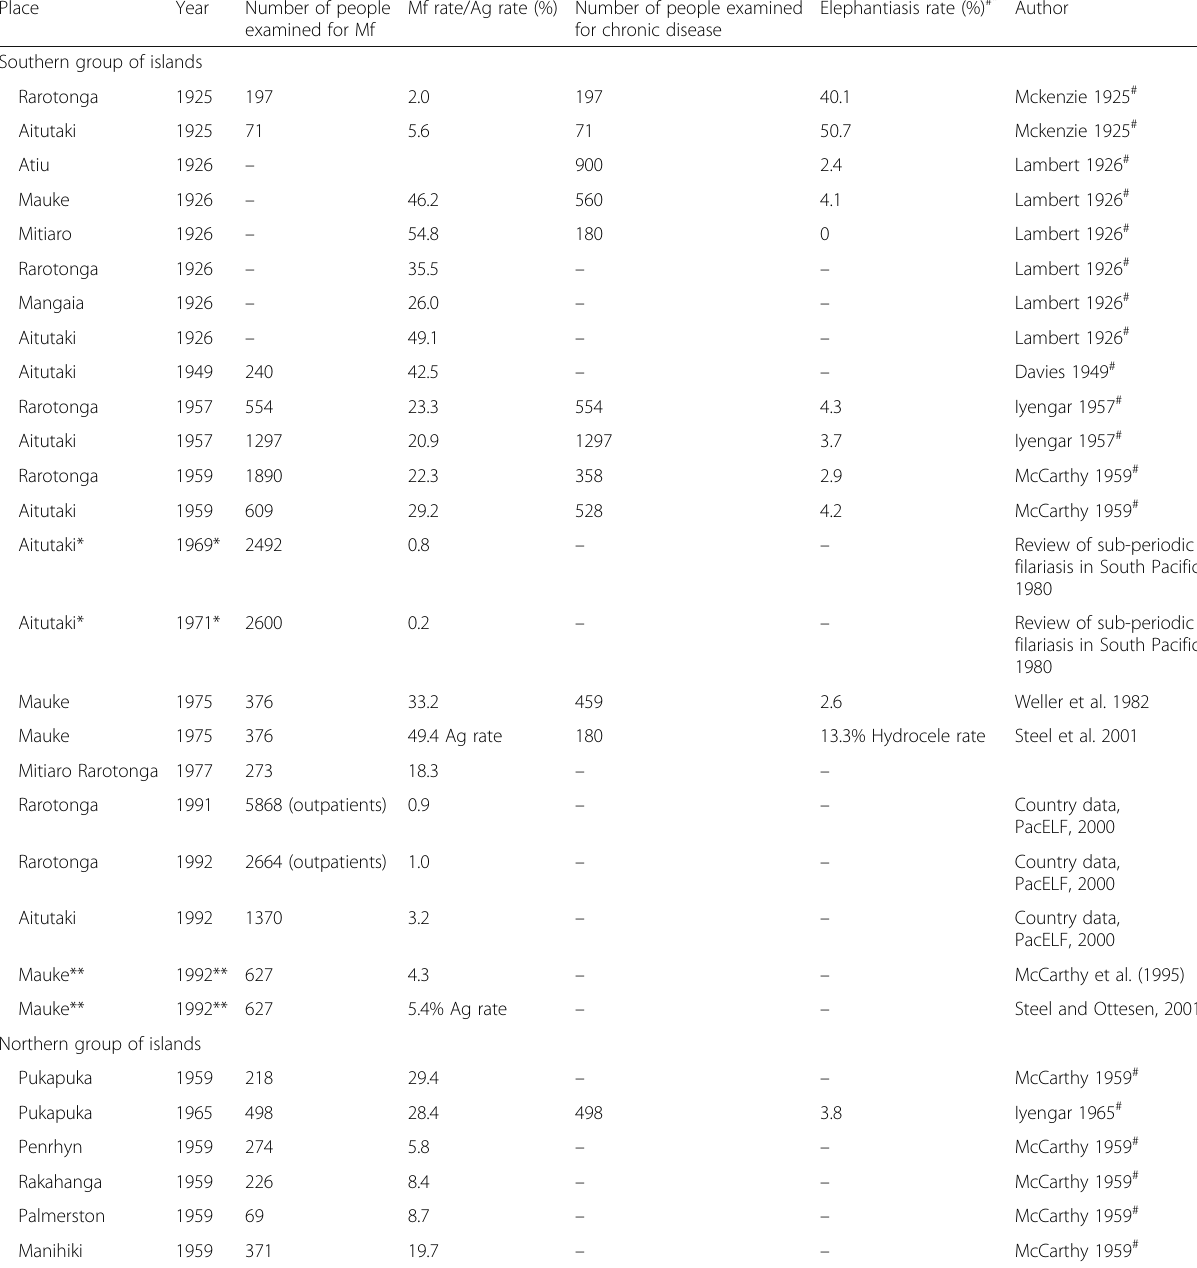
Table 1 The Mf rate and disease rate reported in various studies in the Cook Islands Place Year Number of people Mf rate/Ag rate (%) Number of people examined Elephantiasis rate (%) #* examined for Mf for chronic disease